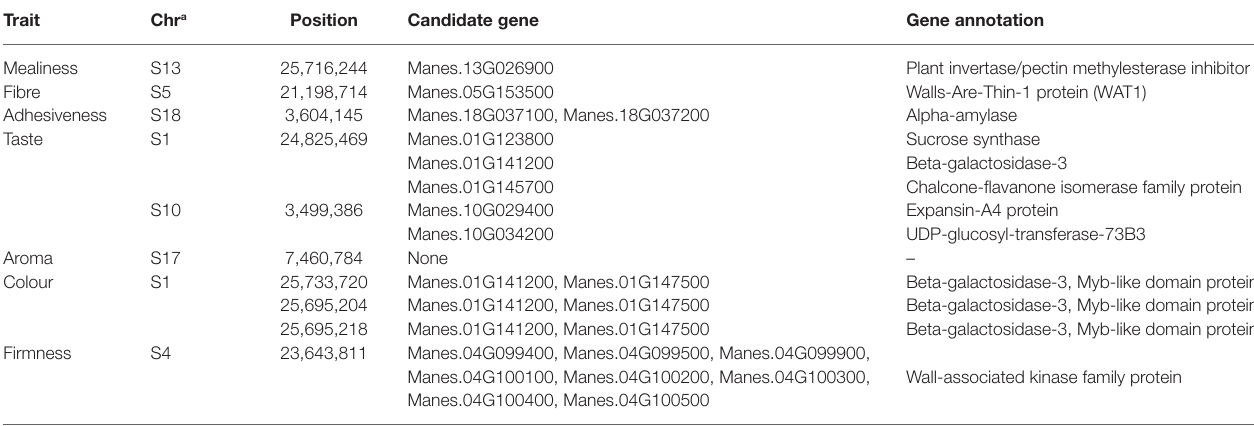
TABLE 3 | Candidate genes co-located with significant SNPs associated with mealiness and other textural attributes of boiled cassava roots. Trait Chr a Position Candidate